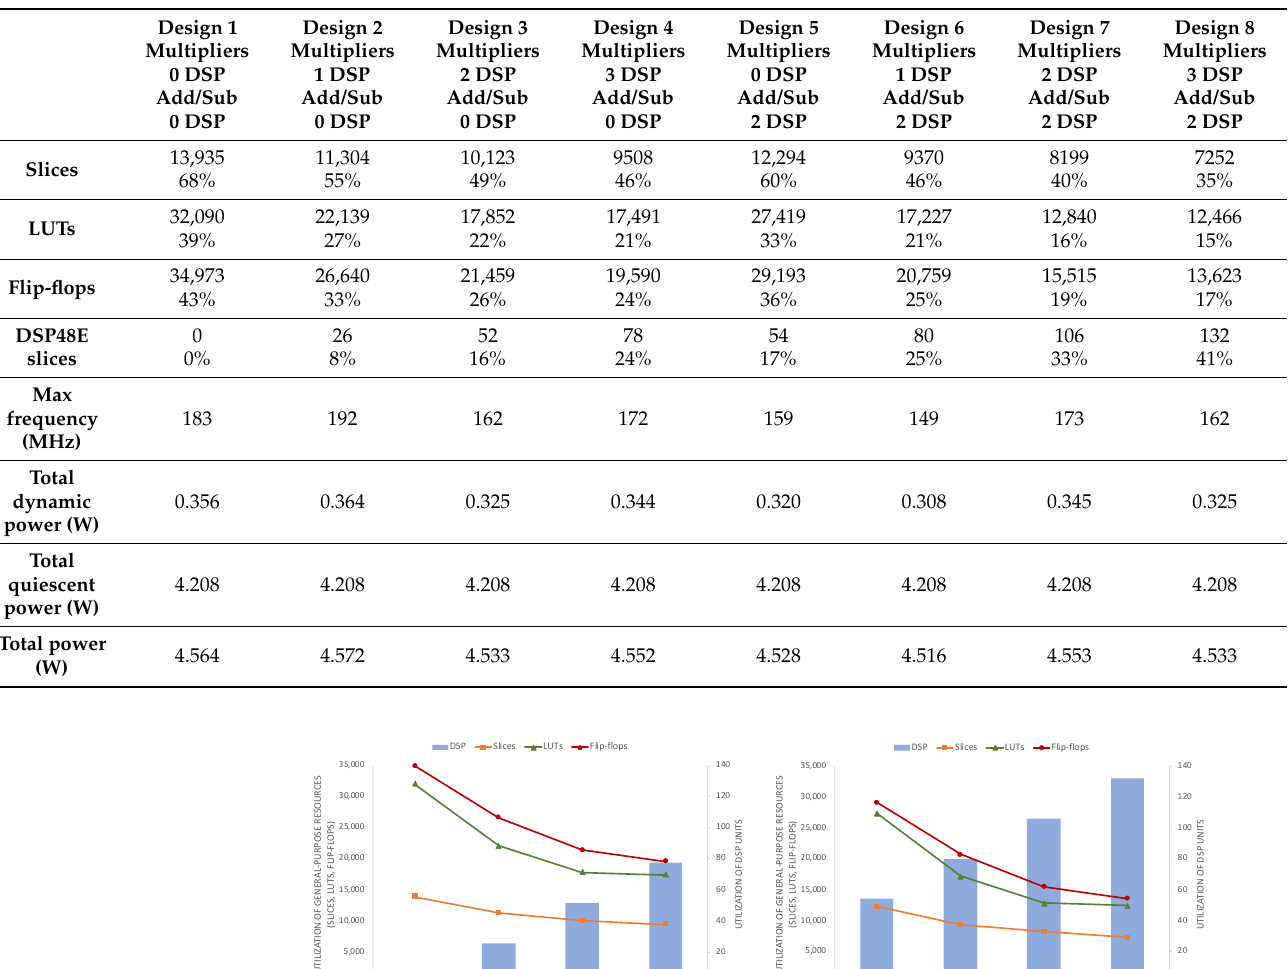
Table 4. Design space exploration—resource utilization, max frequency, and power consumption for different design configurations using different numbers of DSP units for implementing floating-point multipliers, adders, and subtractors.